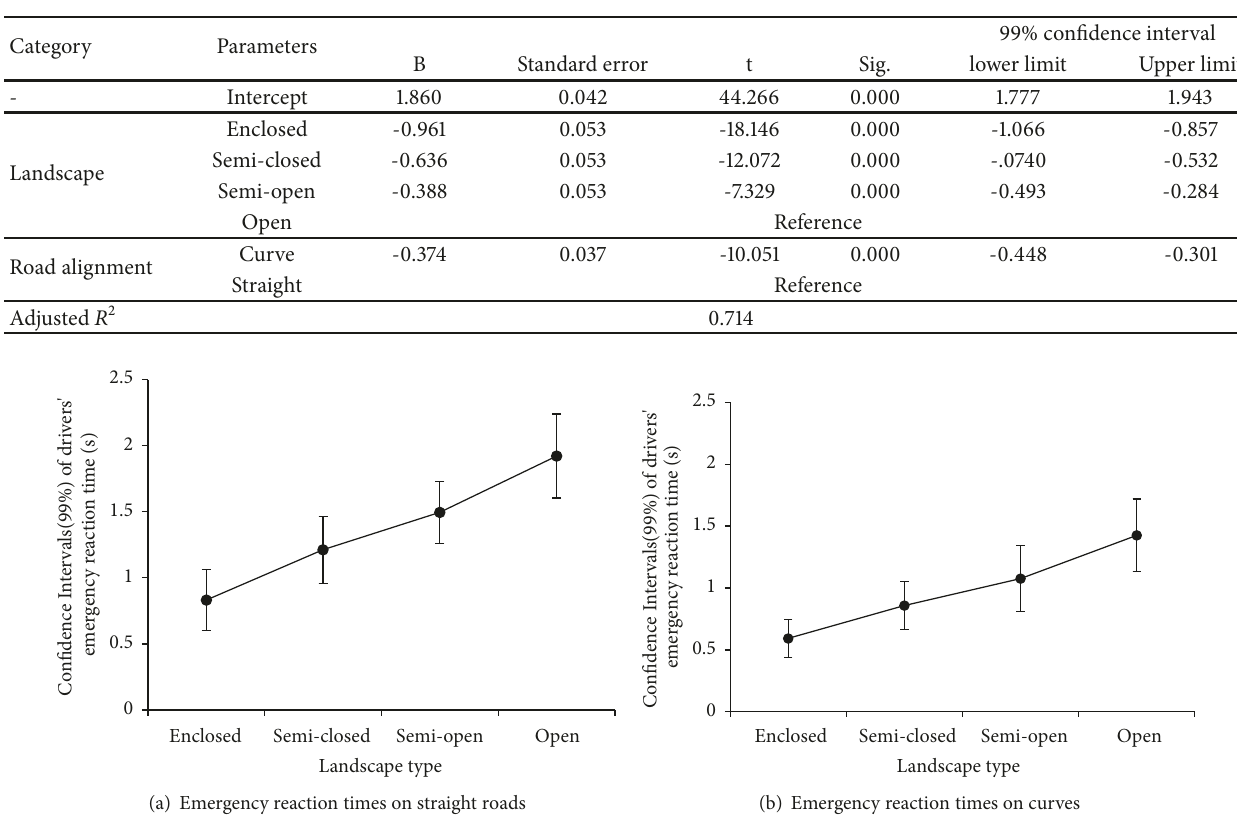
Figure 8: Confidence intervals of drivers’ emergency reaction times for different